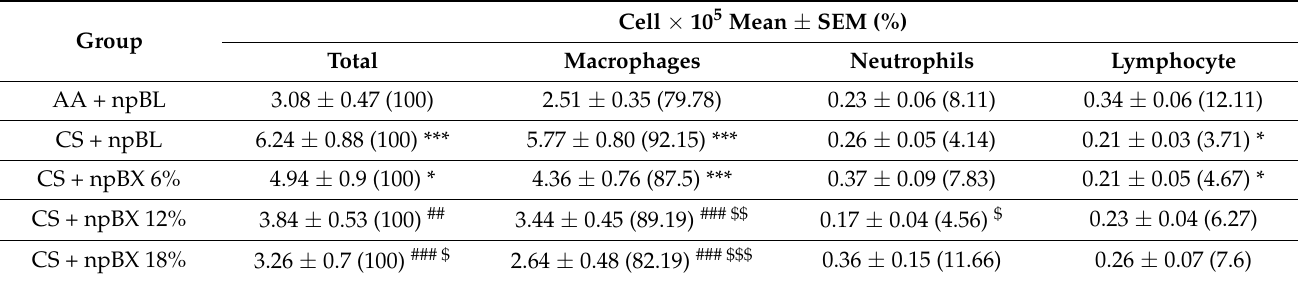
Table 2. Total and differential leukocyte cell counts in BALF samples from 8 animals per group.